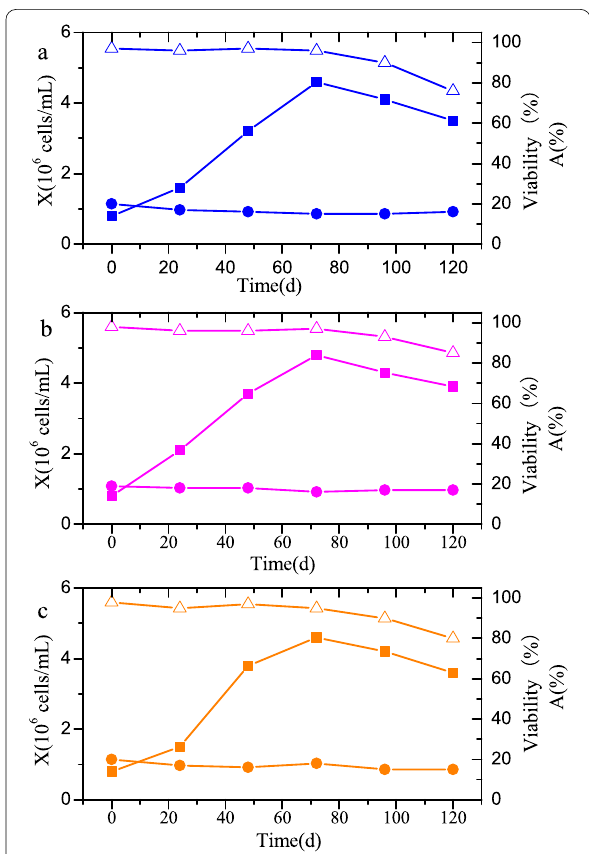
Fig. 6 Viable cell density ( X , filled square), viability (triangle), and the ratio of aggregated cells ( A , filled circle) in batch cultures of BHK-21 cells in 42- ( a ), 350- ( b ), and 1000-L ( c ) bioreactors